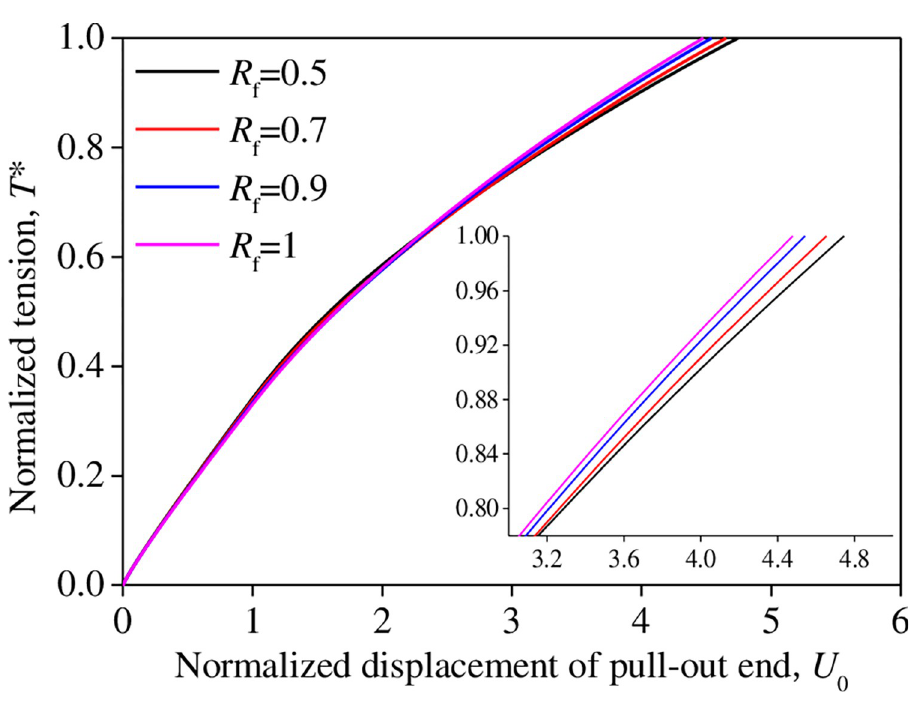
Fig 8. Influence of R f on the T � – U 0 relationship.